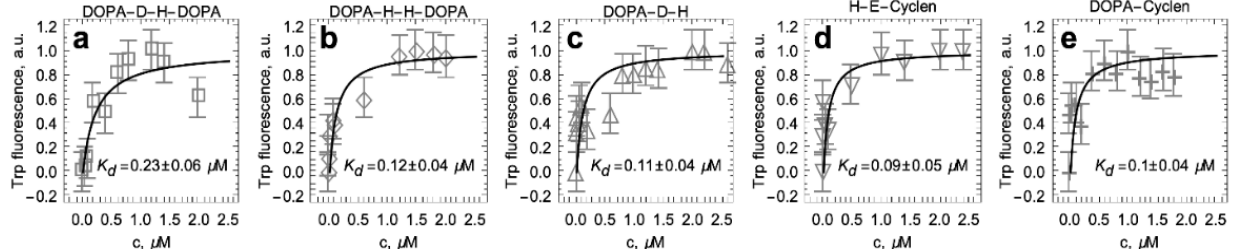
Figure 4. Binding of DOPA and cyclen-based compounds to native S100A9 followed by intrinsic fluorescence. ( a – e ) Normalized titrations of S100A9 by corresponding compounds. Each compound is indicated above corresponding figure ( a – e ) and their K d in captions. Symbols indicate the experimental data points and lines the fitting with a single binding site model. 75 µ M S100A9, PBS, pH 7.4, and 20 °C.